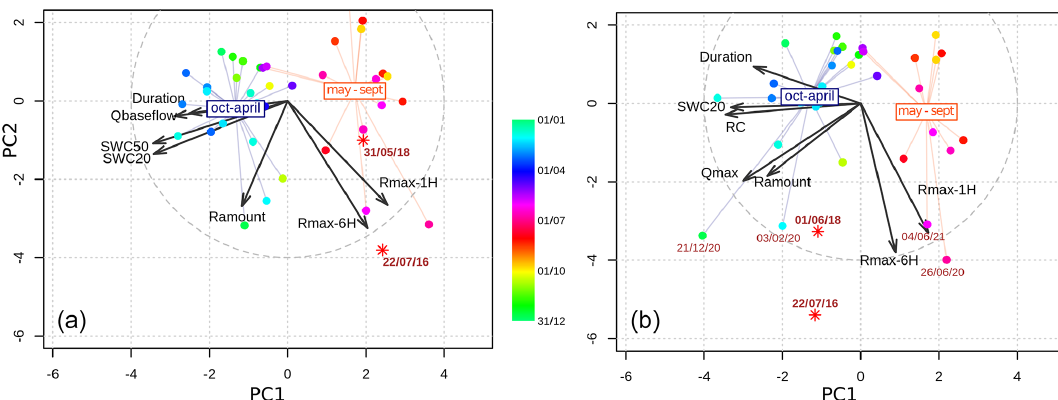
Figure 4. Overview of the events from August 2019 to July 2021. (a) Principal component analysis (PCA) taking into account rainfall properties and the wetness state of the Ernz Blanche catchment at Medernach. (b) PCA including hydrological response properties (Qmax: peak discharge and RC: runoff coefficient). The two flash flood events of 2016 and 2018 are positioned on the figure using the Larochette Catchment data. The extraordinary event of the 13 July 2021 plots out of the lower left corner of the frame.